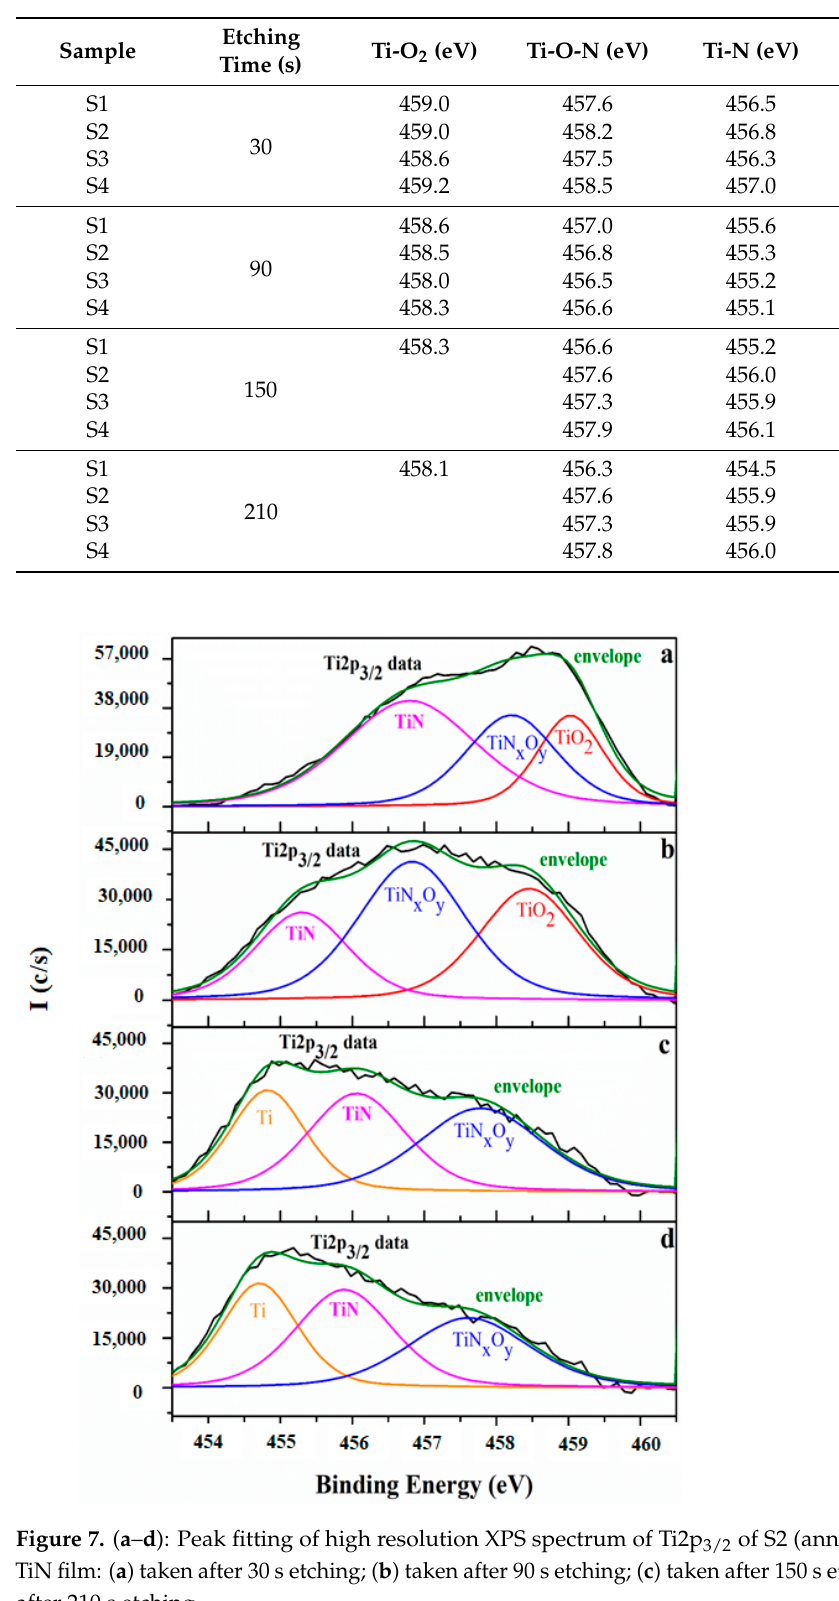
Table 2. Peak positions of deconvoluted Ti2p 3/2 .